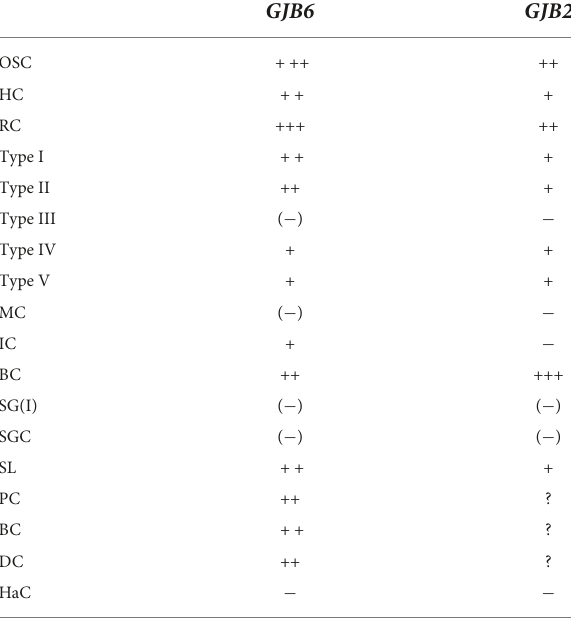
TABLE 2 RNA gene